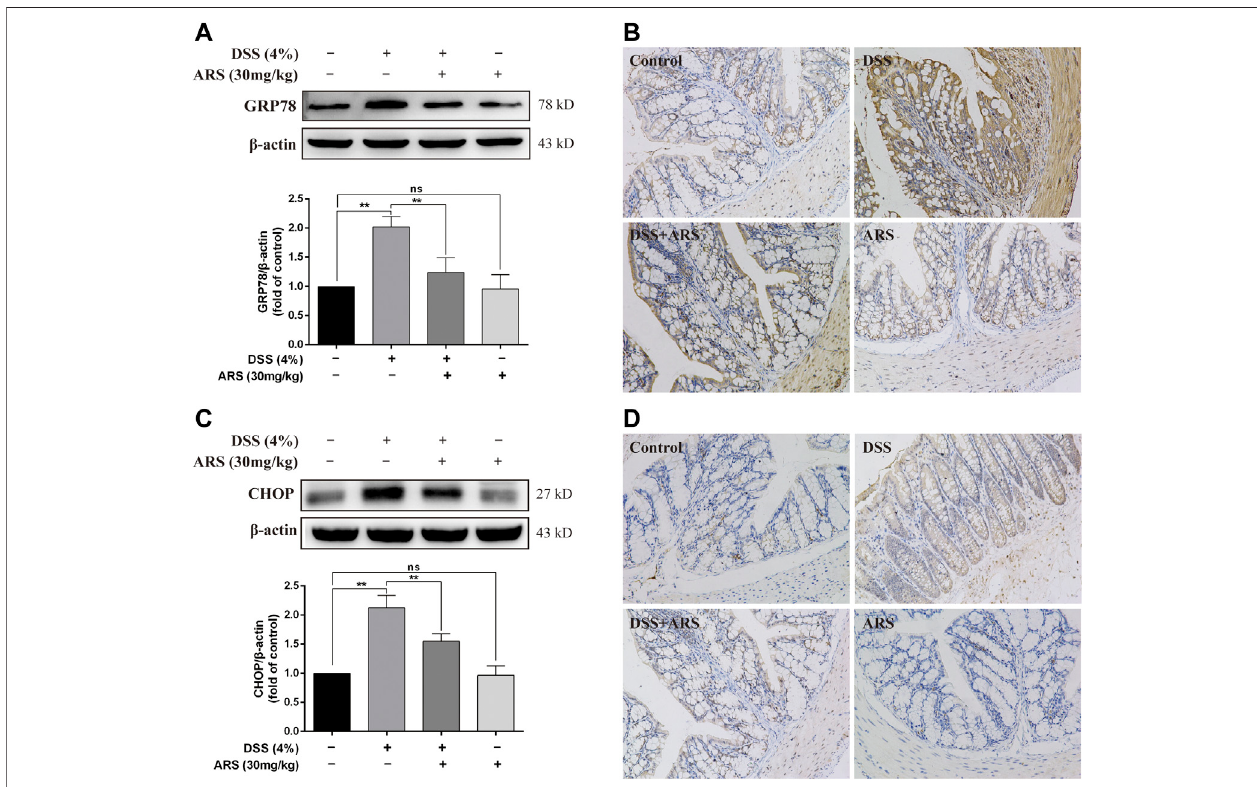
FIGURE 1 | ARS attenuated ER stress in DSS-challenged colon tissues. (A) The immunoblot analysis and (B) immunohistochemistry test of GRP78 in the colonic tissues from each group. (C) The immunoblot analysis and (D) immunohistochemistry test of CHOP in colonic tissues. Data are presented as mean ± SD ( n (cid:1) 3). * p < 0.05, ** p <